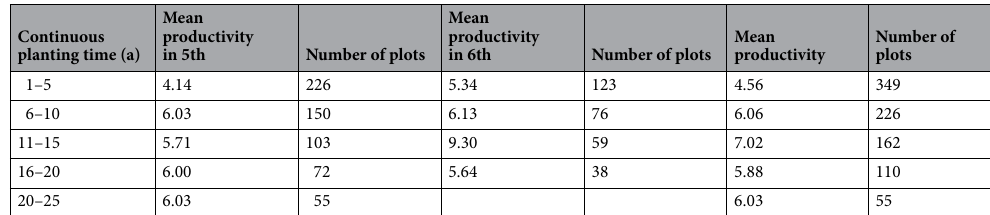
Continuous planting time (a)